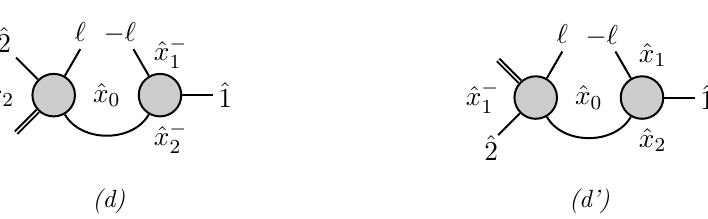
Figure 11. Two di(cid:11)erent (but equivalent) ways to depict diagram (d) of the previous (cid:12)gure. In the (cid:12)rst depiction ‘ = ^ x (cid:0) while in the second ‘ = ^ x 10 , which di(cid:11)ers from the previous one by q . 10 We can now show that the right-hand side of (4.54) is nothing but (^ x note that (cid:26) = (cid:26) (cid:0) , from the de(cid:12)nition (4.35) and the fact that (cid:21) i i have to show